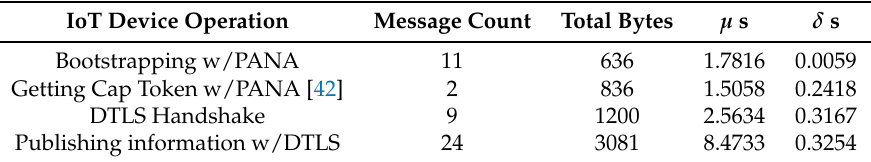
Table 1. Number of exchanges and bytes per IoT device operation.